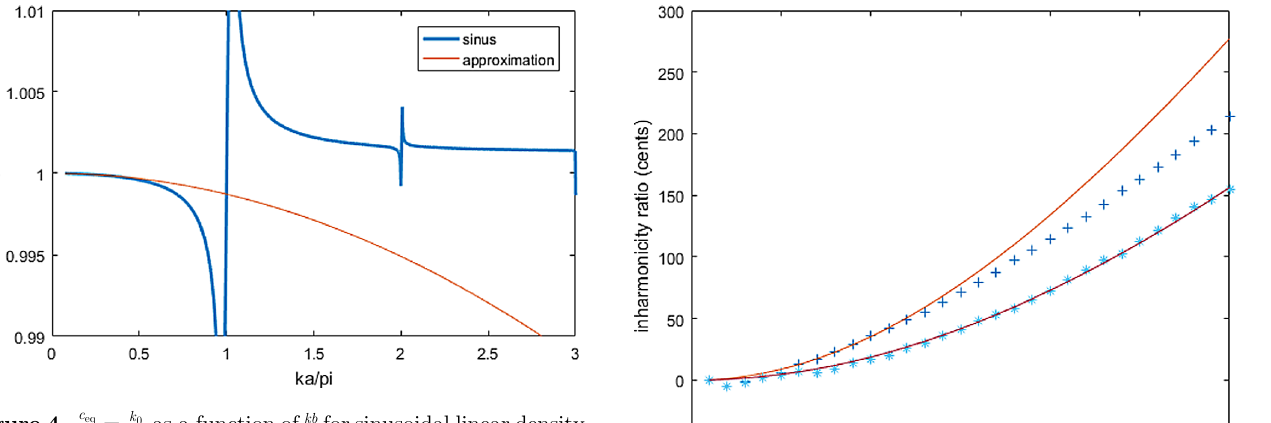
(cents) versus harmonic ffiffiffiffiffiffiffiffiffiffi p nf 1 ffiffiffiffiffiffiffi 1 þ Bn 2 p with 1 þ B